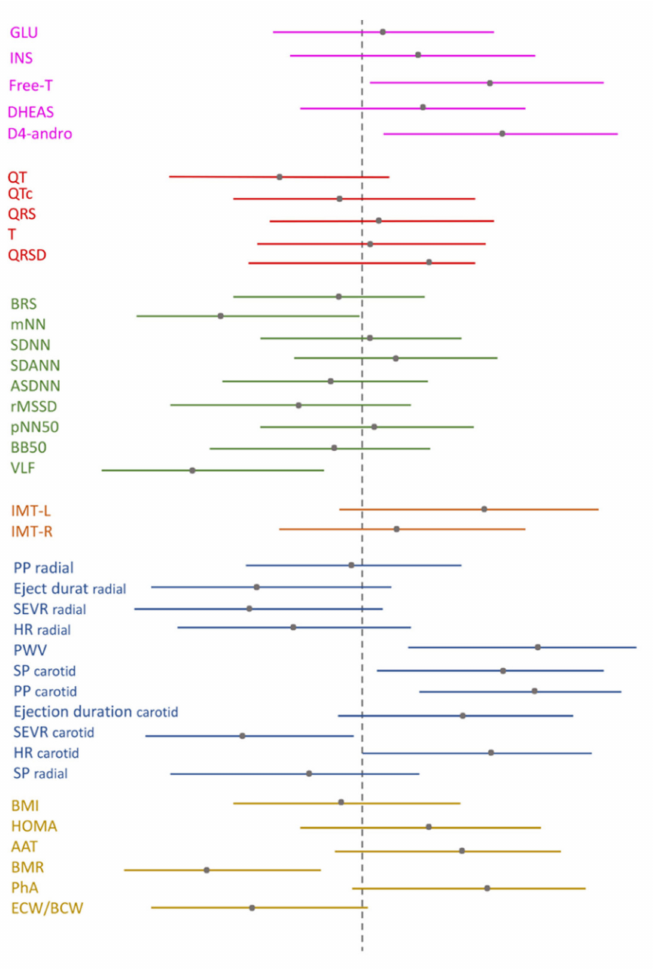
Figure 2. Differences between case-control groups are presented in Hedge’s g (correction of Cohen d for small samples) and 95% Confidence